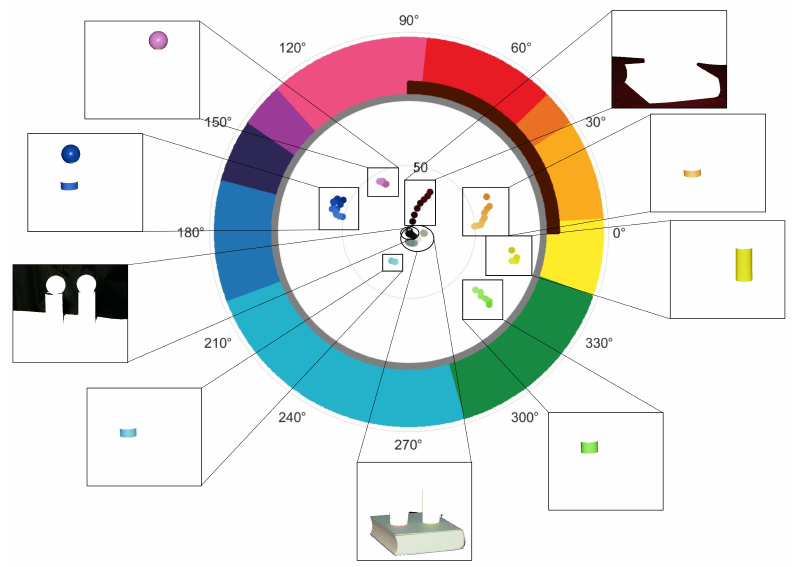
Figure 7. Segmentation of sample image BONCH-01 of the ITTP-Close experimental dataset, using class remodeling of ABANICCO’s detected colors as clustering-based image